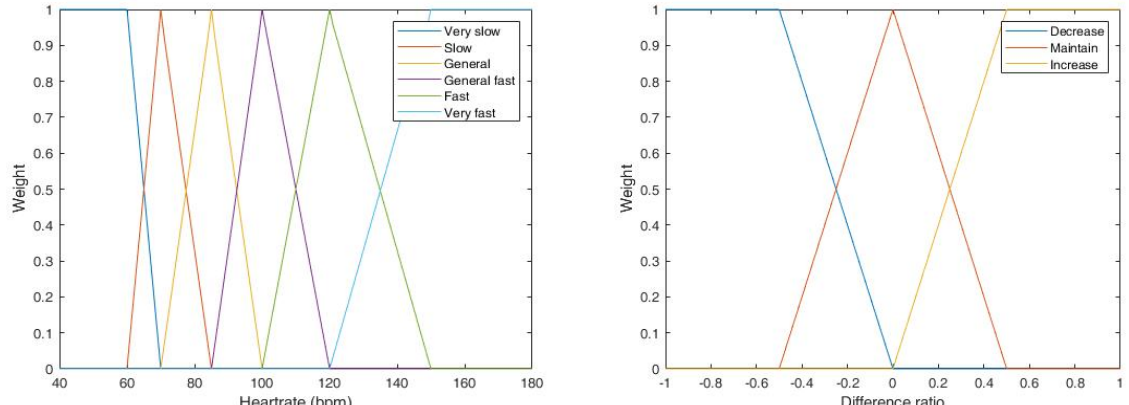
Figure 13. Membership functions of heart rate ( left ) and the difference ratio ( right ). Fuzzy input 2 considers the heart rate tendency through the change of latest heart rates and the maximum difference of the previous k heart rates. Table 3 describes the relationship between heart rate and peak interval. Denote the Difference Ratio (DR) as the ratio of the change of latest heart rates, HR t − 𝐻𝑅 t i − 1 , to the maximum difference of the previous k heart rates, τ t , which yields: